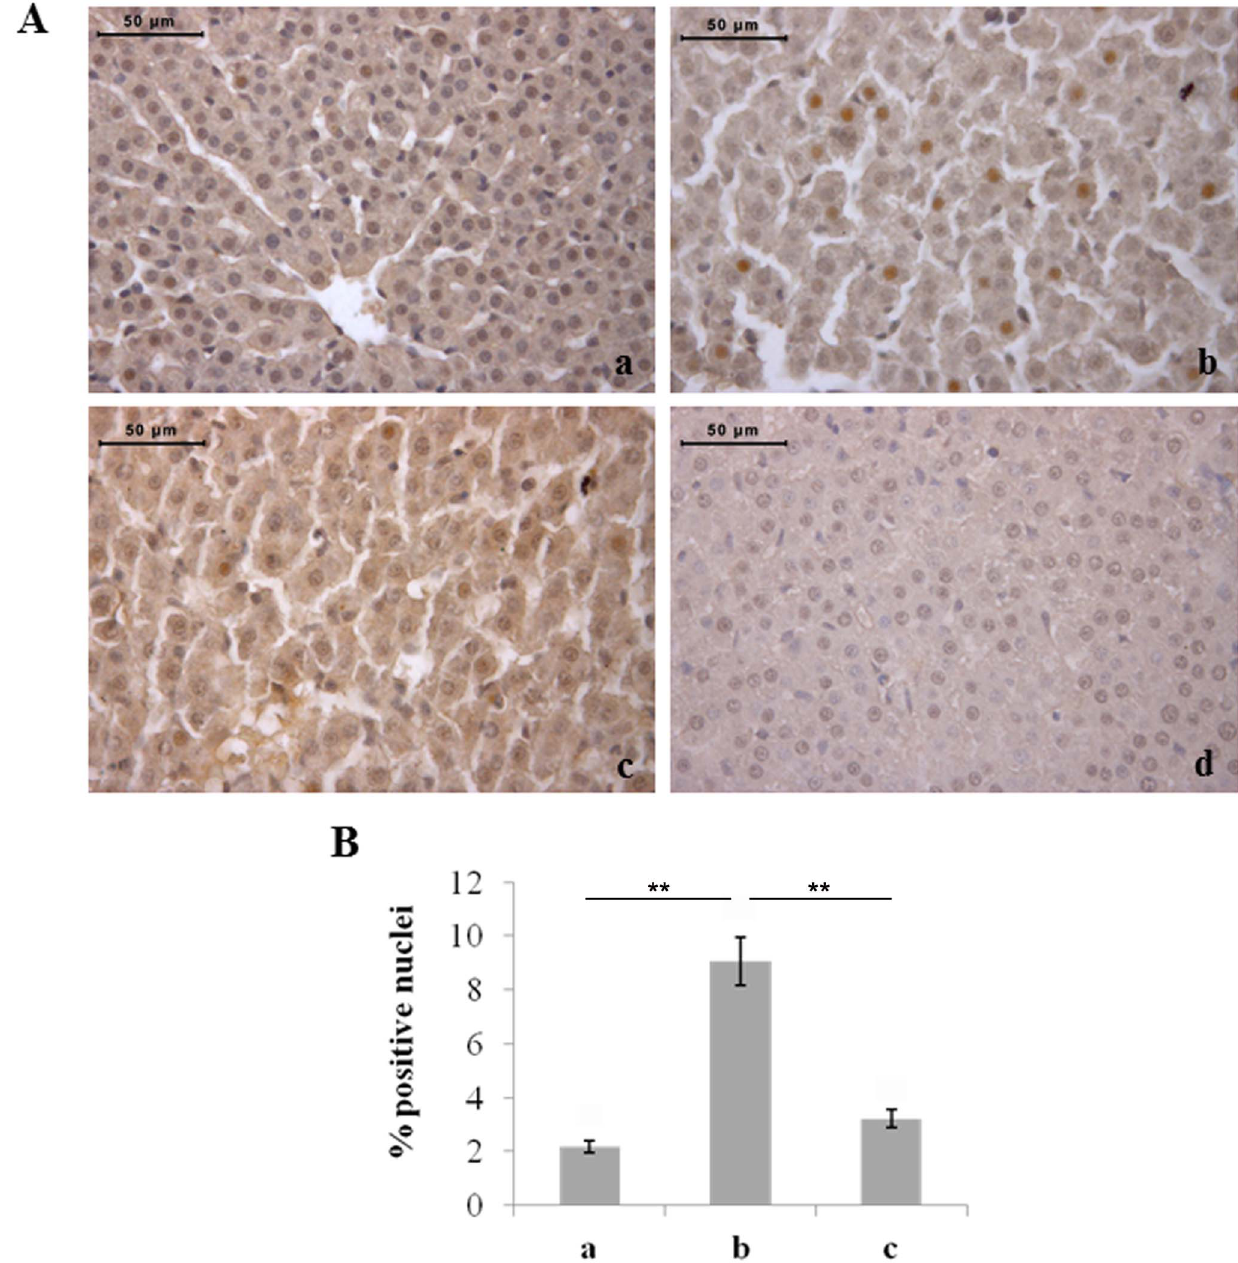
Figure 7. Moderate hyperoxia increases the number of HIF-1 a -positive hepatocytes with respect to normoxia and severe hyperoxia. A) Immunohistochemical detection of HIF-1 a expression in neonatal rat livers exposed to moderate and severe hyperoxia. a) ambient air; b) 60% hyperoxia; c) 95% hyperoxia; d) negative control; scale bar: 50 m m, magnification 40x. B) Graphic representation of the percentages of HIF-1 a positive nuclei ( 6 SD); densitometric analysis determined by direct visual counting of ten fields for each of three slides per sample. **=p ,